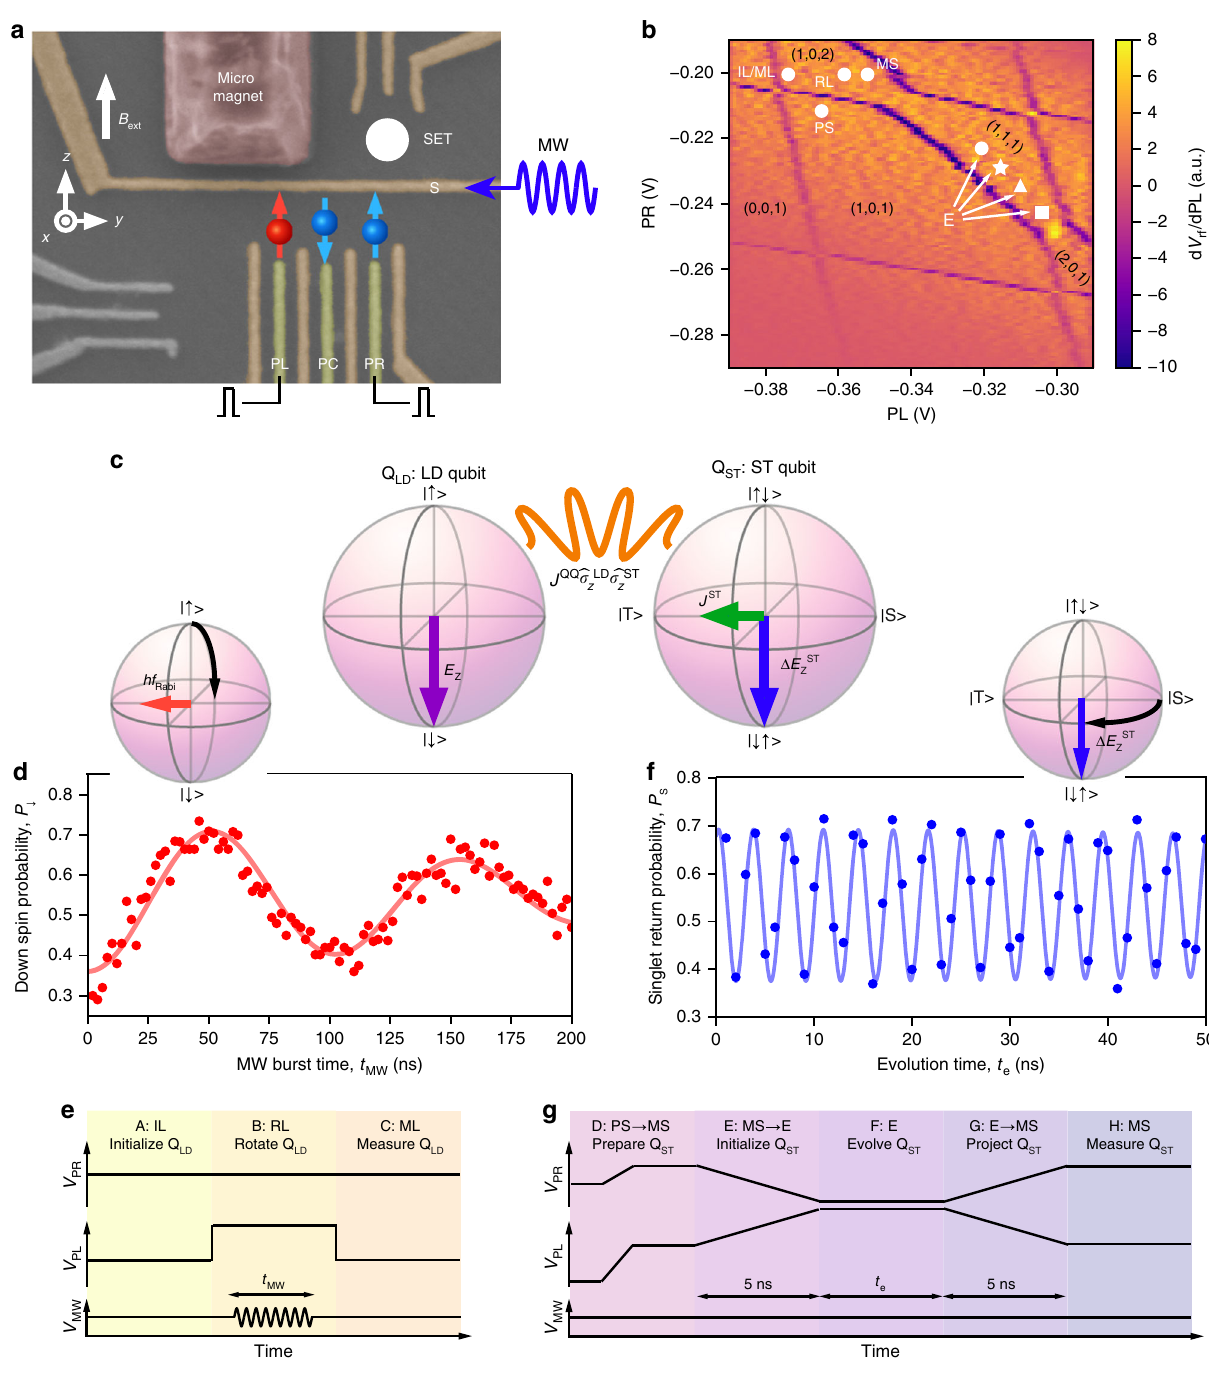
Fig. 1 Hybrid system of a LD qubit and a ST qubit realized in a TQD. a False color scanning electron microscope image of a device identical to the one used in this study. The TQD is de fi ned in a two-dimensional electron gas at the GaAs/AlGaAs heterointerface 100 nm below the surface. The upper single electron transistor is used for radiofrequency-detected charge sensing 24,25 . A MW with a frequency of 17.26 GHz is applied to the S gate to drive EDSR. b Stability diagram of the TQD obtained by differentiating the charge sensing signal V rf . c Hybrid system of a LD qubit and a ST qubit coupled by the exchange coupling J QQ . d Rabi oscillation of Q LD (rotation around x -axis) driven by EDSR with J QQ ~ 0 at point RL in Fig. 1b. The data is fi tted to oscillations = 199 ns. e Pulse sequence used to produce Fig. 1d showing gate voltages V V with a Gaussian decay of T Rabi PL and PR applied to the PL and PR gates and a 2 MW burst V MW . f Precession of Q ST (rotation around z -axis) with a frequency of f ST = 280 MHz due to Δ E ST , taken at point E marked by the white circle in Z (1,1,1) in Fig. 1b, where J QQ and J ST ~ 0. The data follow the Gaussian decay with a decay time of 207 ns (see Supplementary Fig. 2a) induced by the nuclear fi eld fl uctuations 29 . g Pulse sequence used to produce Fig.